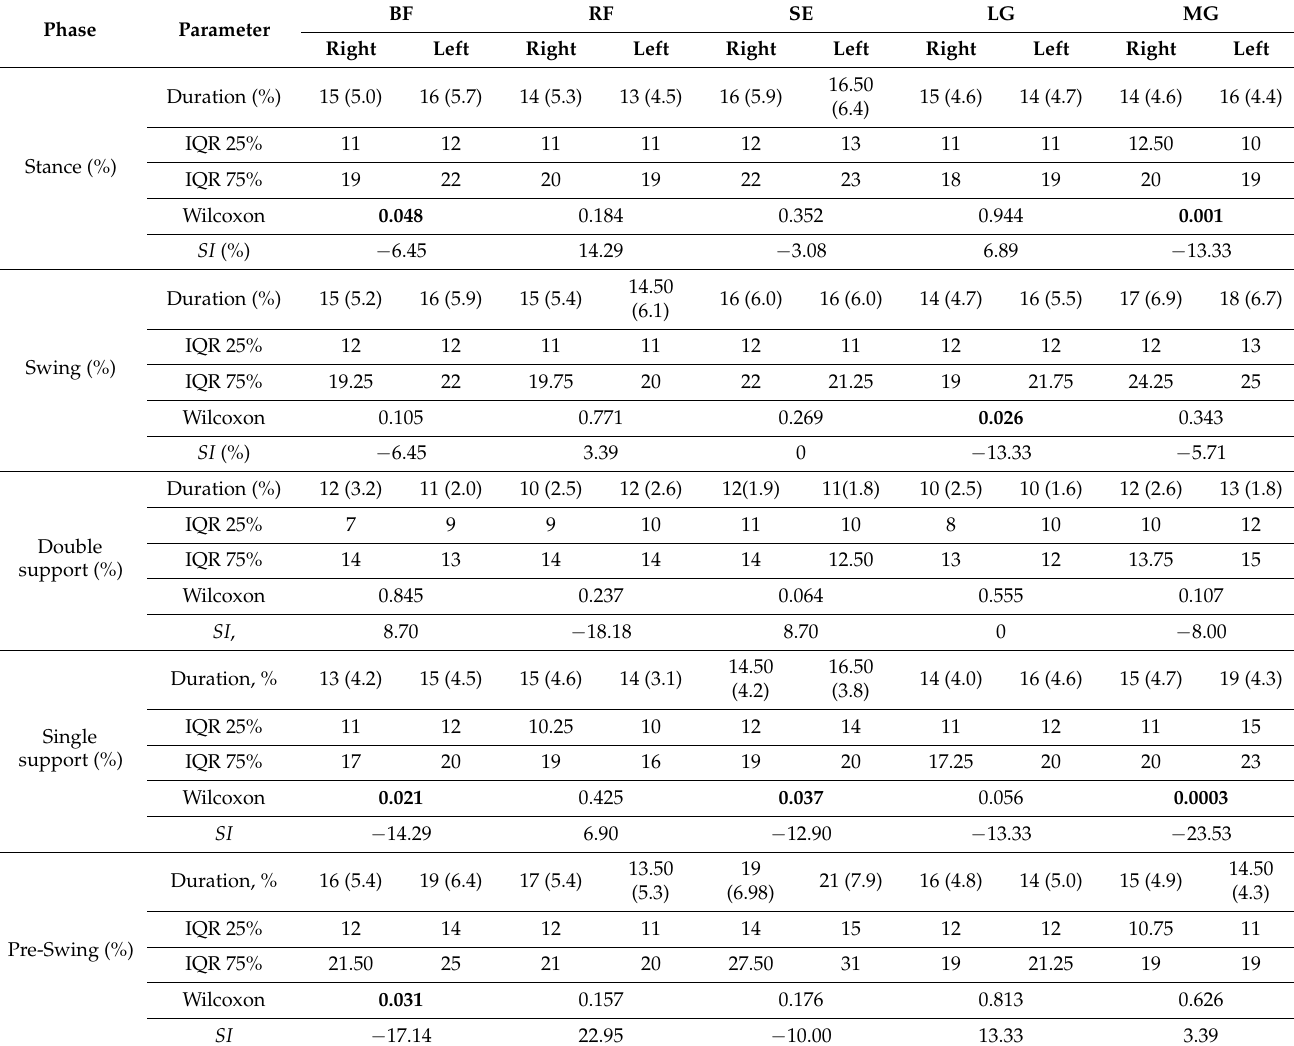
Table 6. Descriptive values of activation duration and SI for each